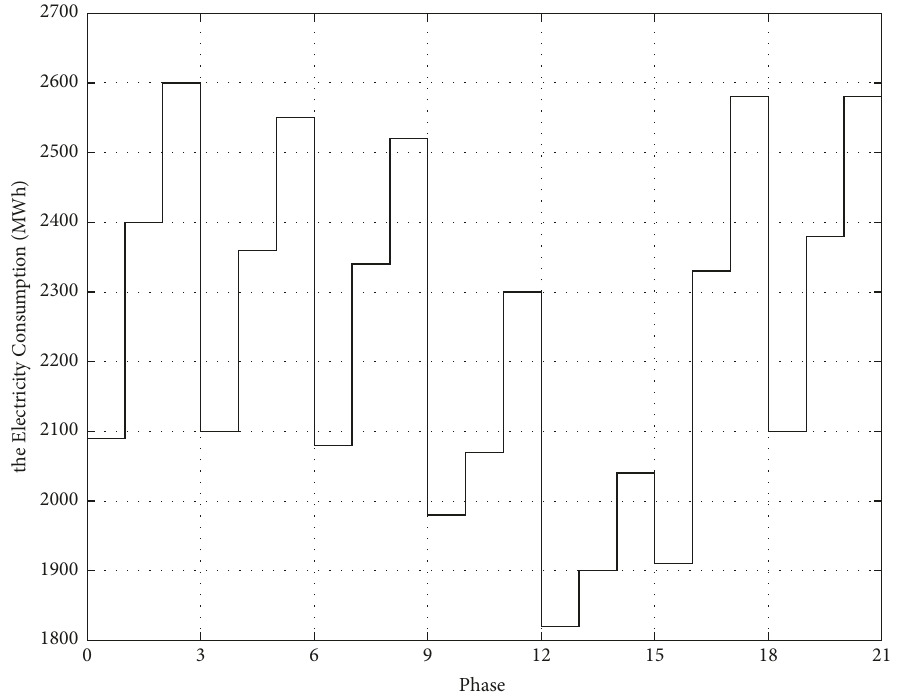
Figure 2: The electricity consumption distribution of the large consumer in the next week.